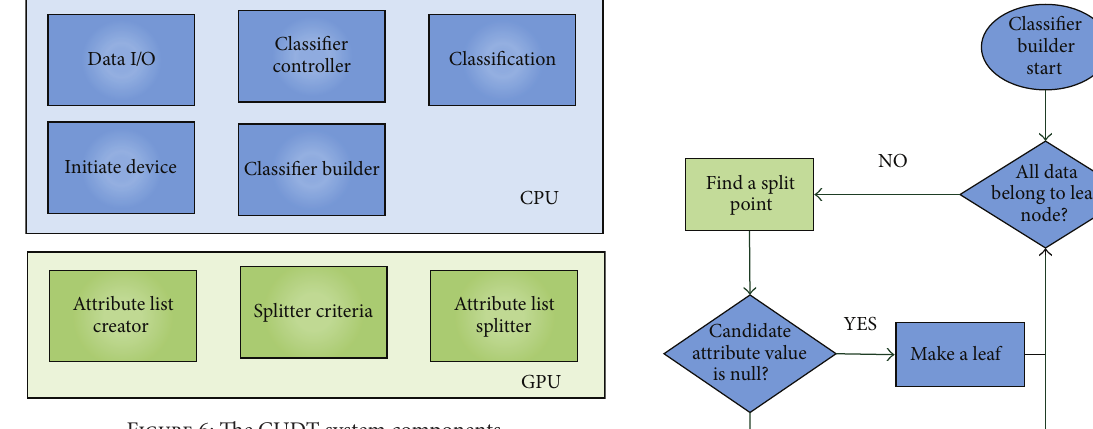
Figure 6: The CUDT system components.